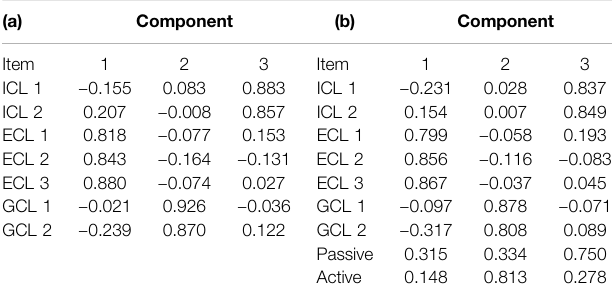
TABLE 5 | Rotated PCA (a) with items from Klepsch et al. (2017) and (b) including the passive and active items for study 2.